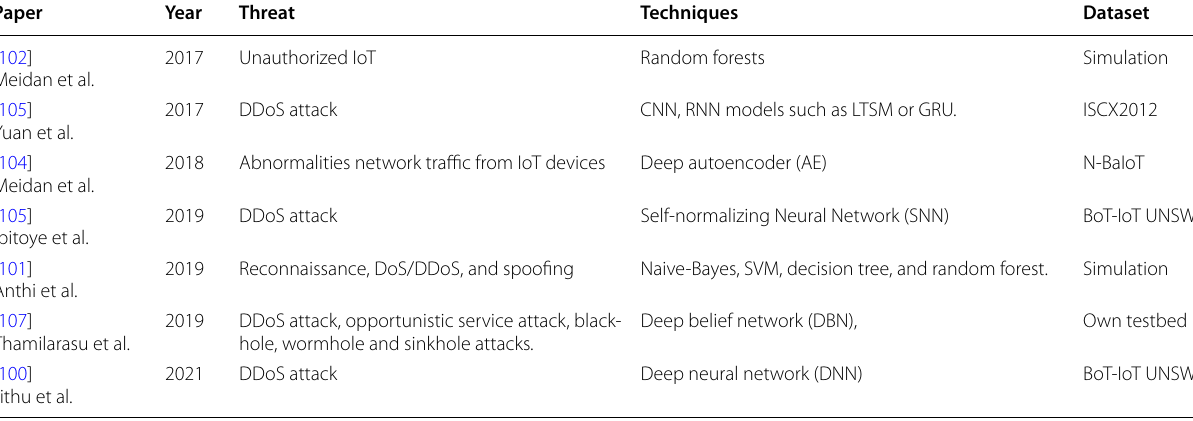
Table 8 Summary of selected works on using ML/DL for cyber security without CEP technology